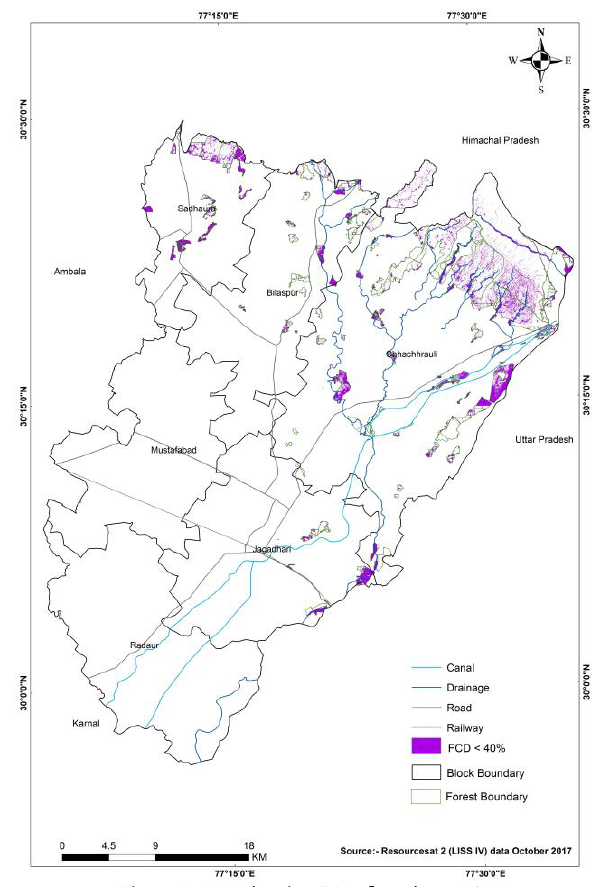
Figure 5. Area having FCD less than